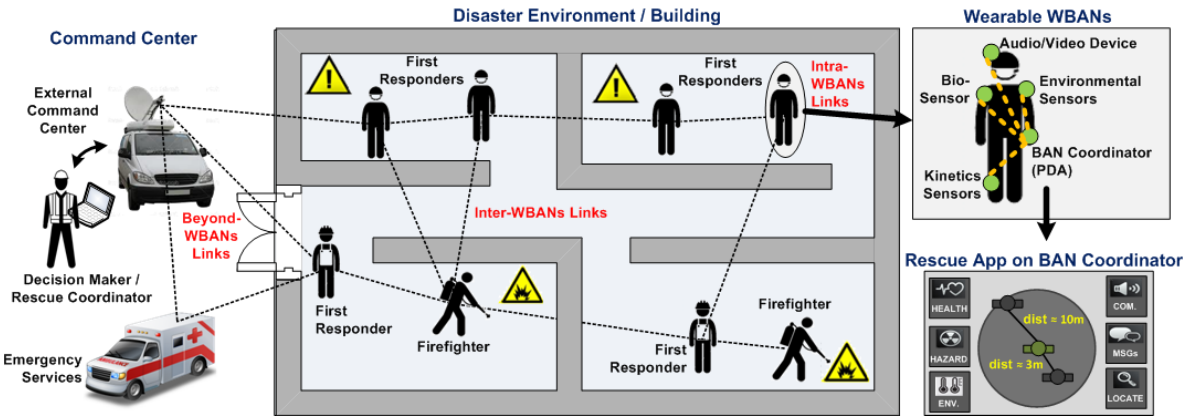
Figure 2. WBANs for Rescue and Emergency Management Application